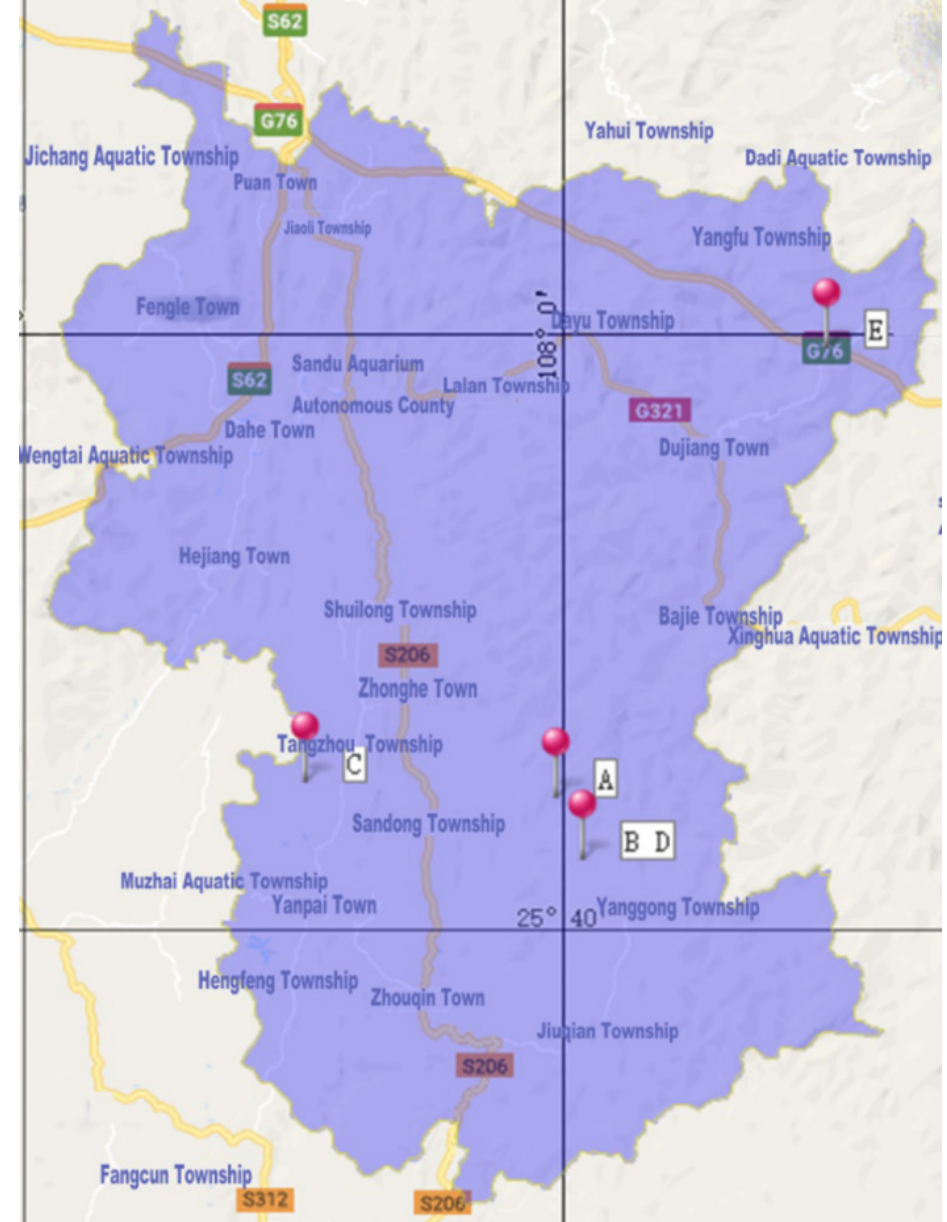
Figure 1. The locations of studied populations of ancient tea plant germplasm used for genetic and